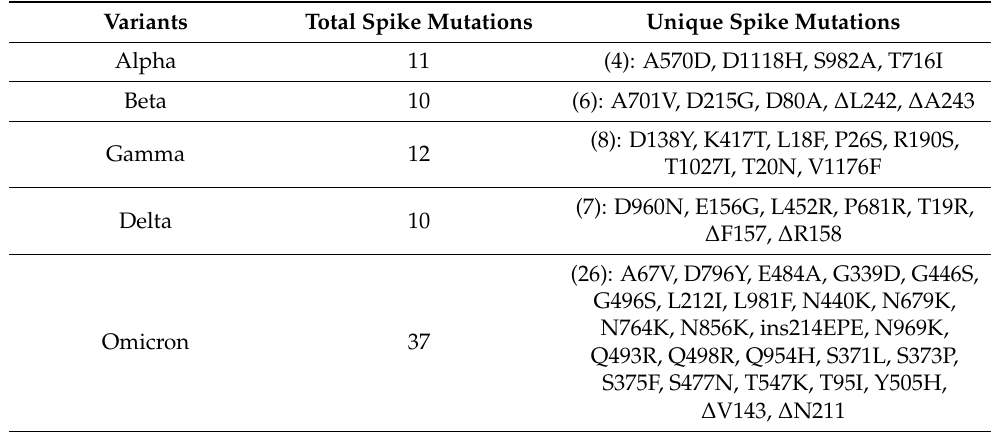
Table 2. Summary of mutational profile of spike mutations in the SARS-CoV-2 variants of concern (Alpha, Beta, Gamma, Delta and